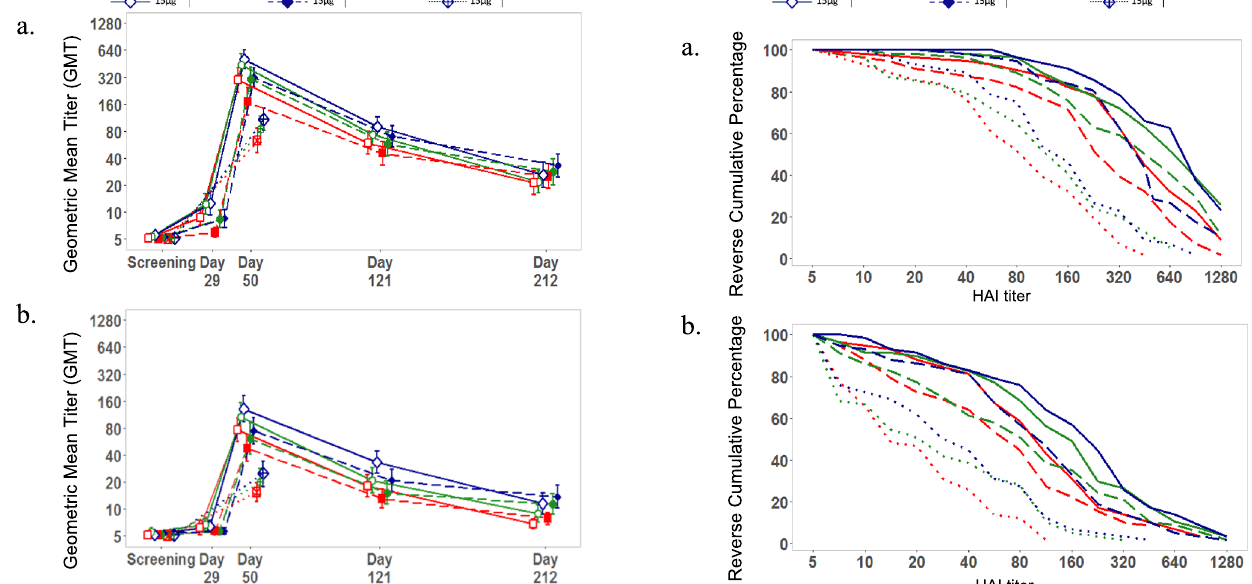
Fig. 5 Reverse cumulative percentages for serum HAI antibody responses generated by adjuvanted recombinant H7 vaccination. AS03-adjuvanted recombinant H7 ( a ) and MF59-adjuvanted recom- binant H7 ( b ) to homologous A/Guangdong/17SF003/2016 (H7N9) and heterologous A/Hong Kong/125/2017 (H7N9) fi fth epidemic viruses as well as heterologous A/Shanghai/02/2013 (H7N9) fi rst epidemic virus (days 1 and 50 only)